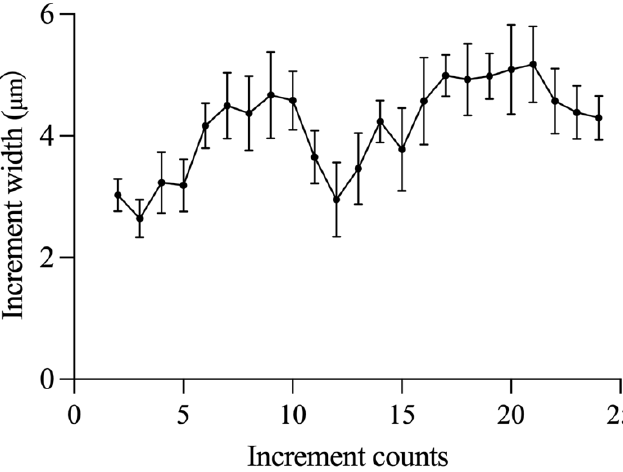
Figure 7. Daily increment widths (mean ± SD) of the lapilli.